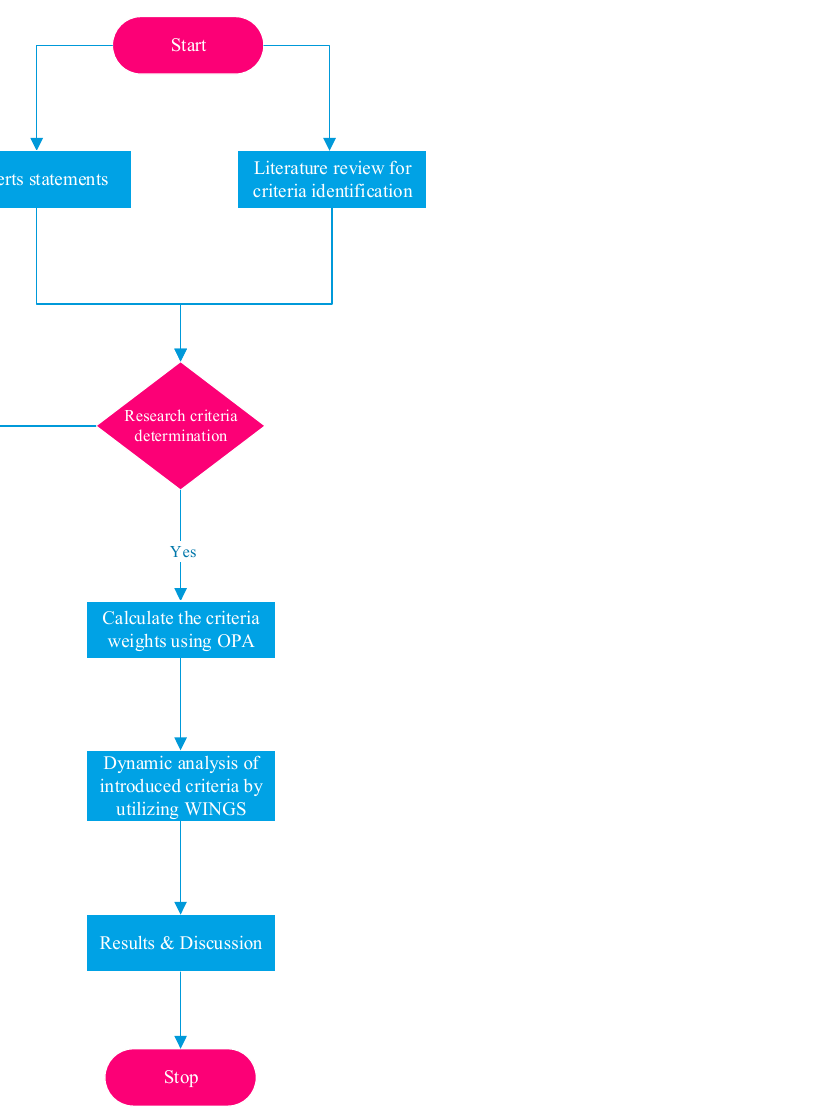
Figure 1. Research flow